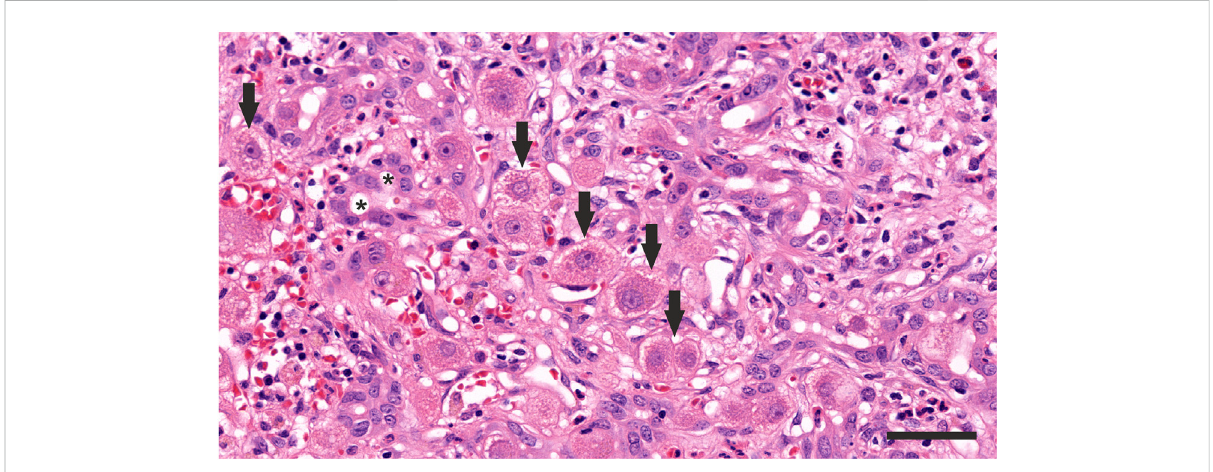
FIGURE 4 Histopathology of the liver of a child in the United Kingdom with AS-Hep-UA in which AAV-2 was detected. Severe hepatitis is present, with cytoplasmic vacuolation of hepatocytes (arraws) as well as a prominent proliferation of the bile ductules (*) and in fi ltration with